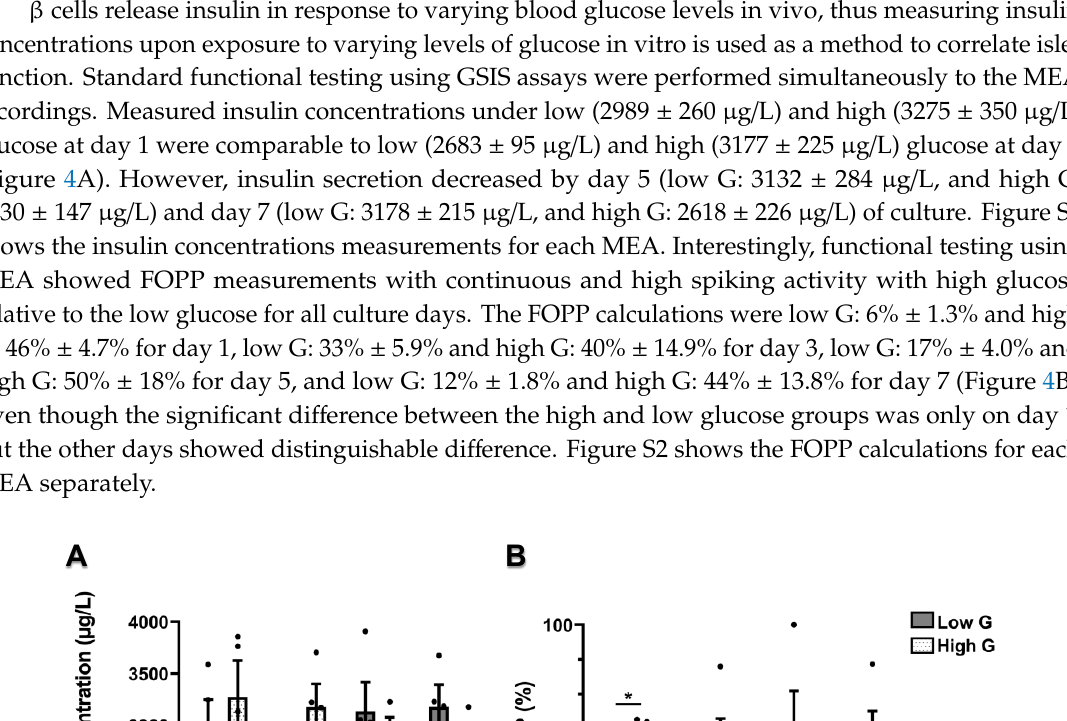
Figure 3. Total spiking with a bin size of 10 s for a total of 30 min recording. Each MEA was recorded with low glucose (1.1 mM) media for 900 s followed by another 900 s recording with high glucose (16.7 mM) media starting from day 1 post seeding until day 7. The number of spikes were summed every 10 s until the end of the recording.